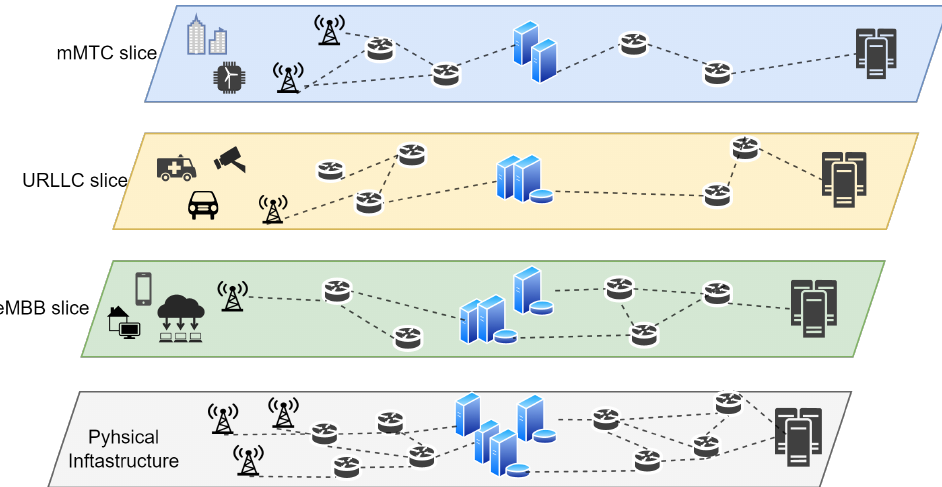
Figure 1. The role of edge computing and slicing for different type of